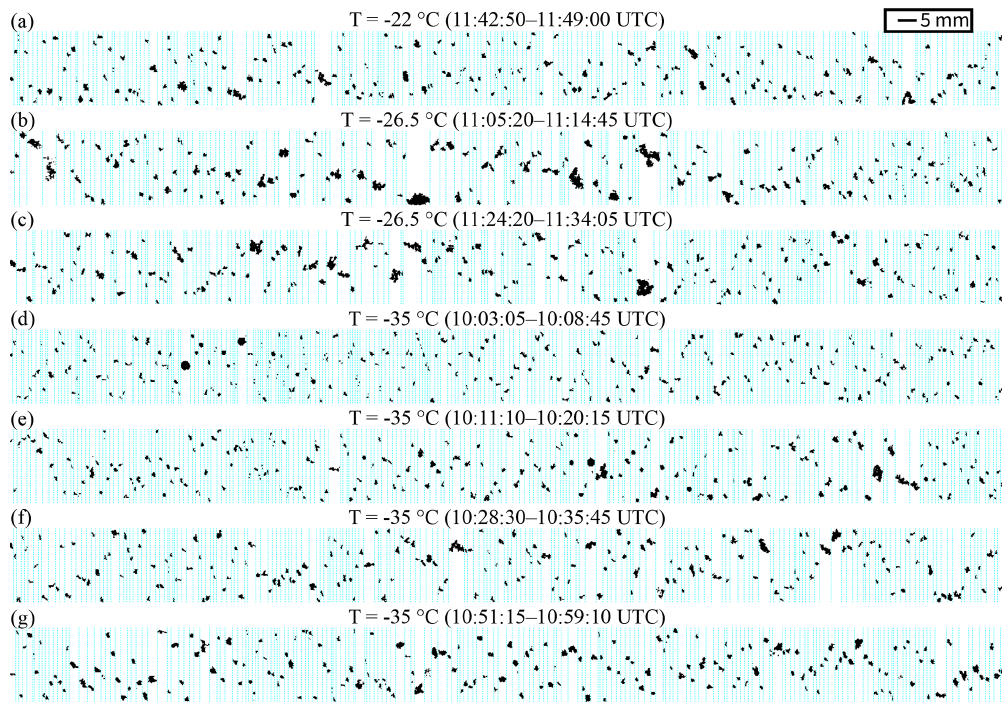
Figure 10. Representative particle images from the HVPS-3 for each near-constant-temperature flight leg on 25 April 2011.